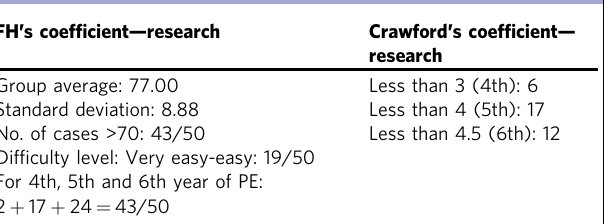
Table 8 Readability of the